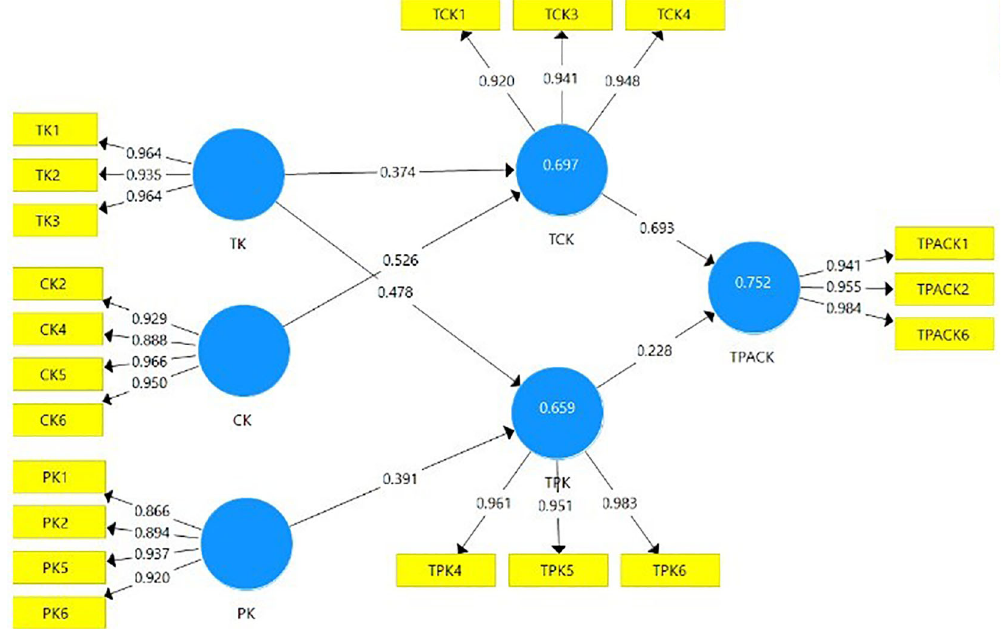
Figure 3. Proposed model with the adoption of TPACK